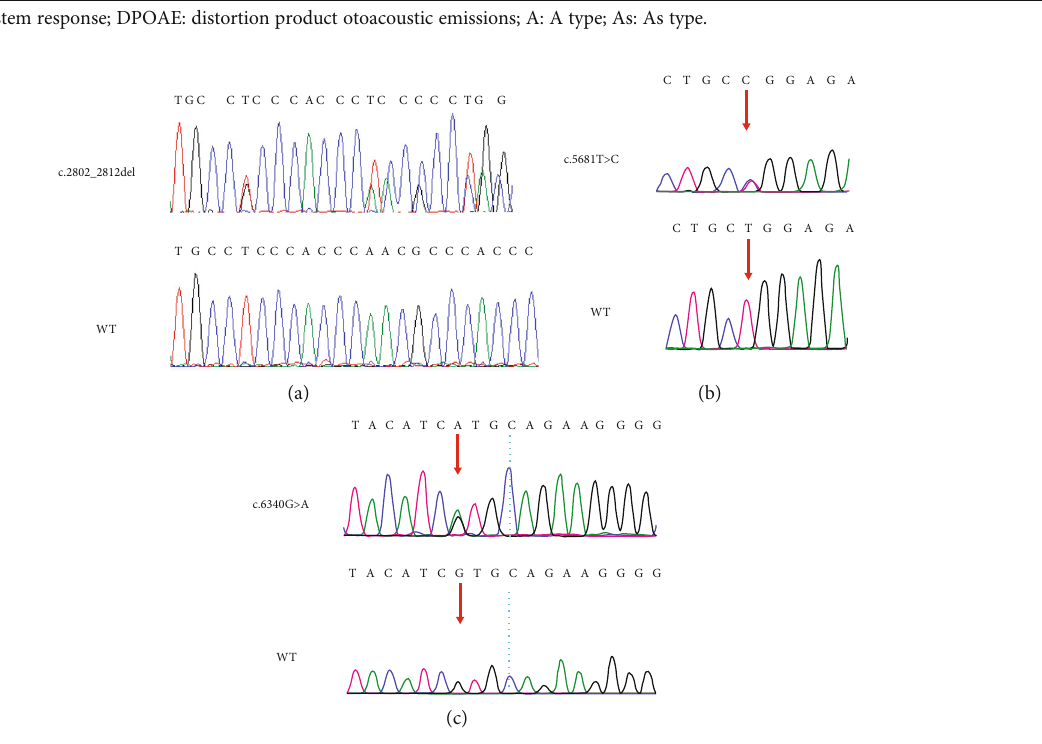
Figure 2: Sanger sequencing results of the c.2802_2812del (a), c.5681T > C (b), and c.6340G > A (c) mutations in the family members. Red arrows: sites of nucleotide